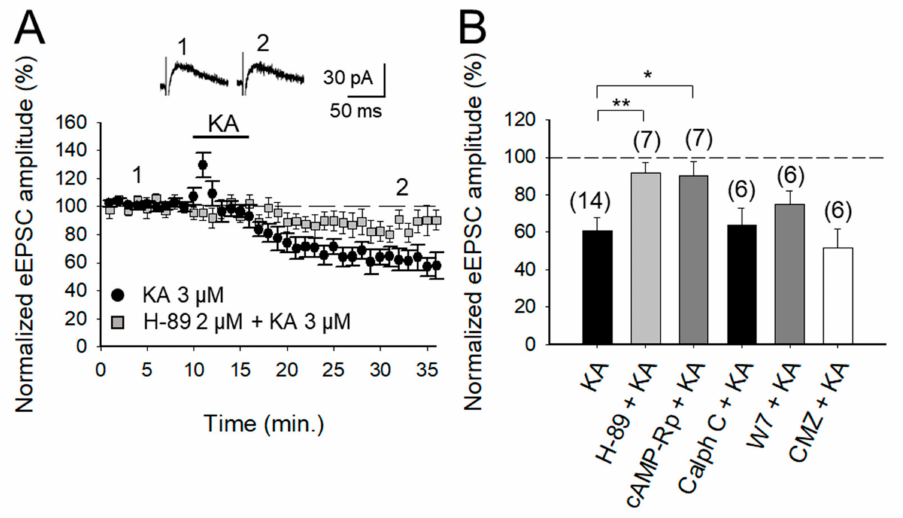
Figure 2. Adenylyl cyclase (AC) and downstream protein kinase A (PKA) underly the KA-mediated depression of glutamate release in PF-PuC synapses. ( A ) Time-course of the e ff ect of KA on eEPSC amplitude in control and H-89 treated slices. Inset shows representative traces showing that KA (3 µ M) does not decrease the amplitude of the eEPSCs in H-89 treated slices. ( B ) Summary of results. Blockade of PKA by H-89 (2 µ M) or cAMP-Rp (100 µ M) prevented the depressive action of KA. Blockade of protein kinase C (PKC) with calphostin C (1 µ M) had no e ff ect on the KAR-mediated decrease of the eEPSC amplitude (when compared to the first bar, KA). Depression similar to non-treated slices was observed on eEPSC amplitude in slices treated with 25 µ M W-7 or 1 µ M CMZ. The number of slices (from two to three mice) is indicated in parentheses at the top of each bar. Results are expressed as means ± SEM (* p < 0.05; ** p < 0.01, ANOVA